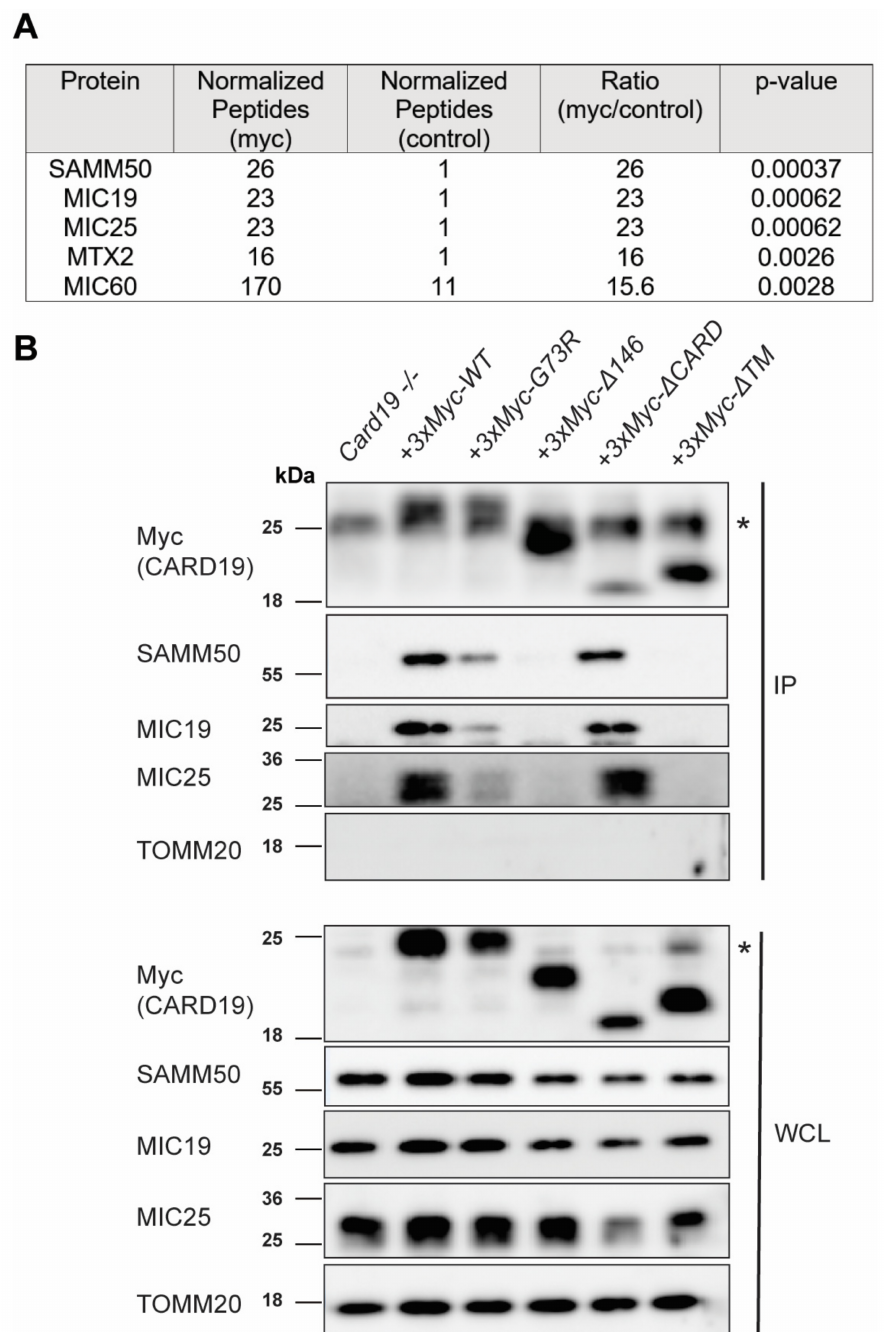
Figure 3. 3 × Myc-CARD19 interacts with MICOS and MIB proteins in macrophages. ( A ) Selected mass spectrometry analysis of immunoprecipitated proteins recovered from Myc affinity resin or control beads using lysates prepared from Card19 − / − immortalized macrophages ectopically expressing 3 × Myc-CARD19-WT. See Supplementary Table S1 for the complete list of significant interacting partners. ( B ) Immunoblotting analysis of anti-Myc immunoprecipitates (IP) or whole-cell lysates were probed with antibodies specific for the indicated proteins. * Indicates the immunoprecipitating antibody light chain in the IP lanes and a non-specific 24 kDa band detected by anti-Myc in the WCL